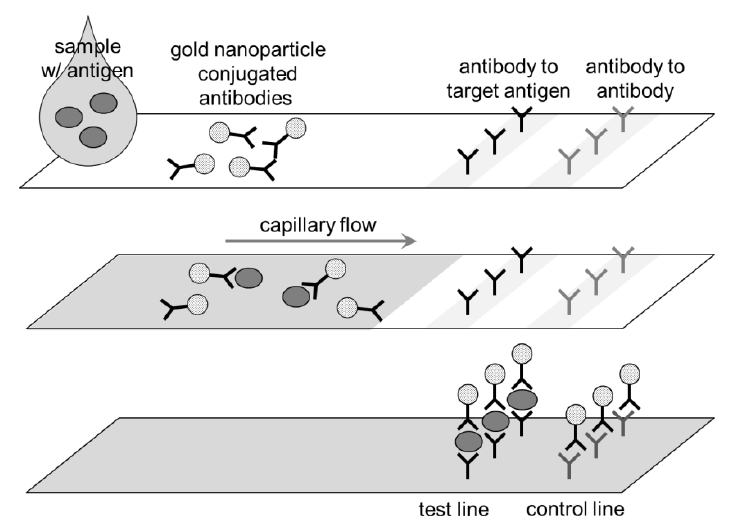
Figure 5. Schematic of